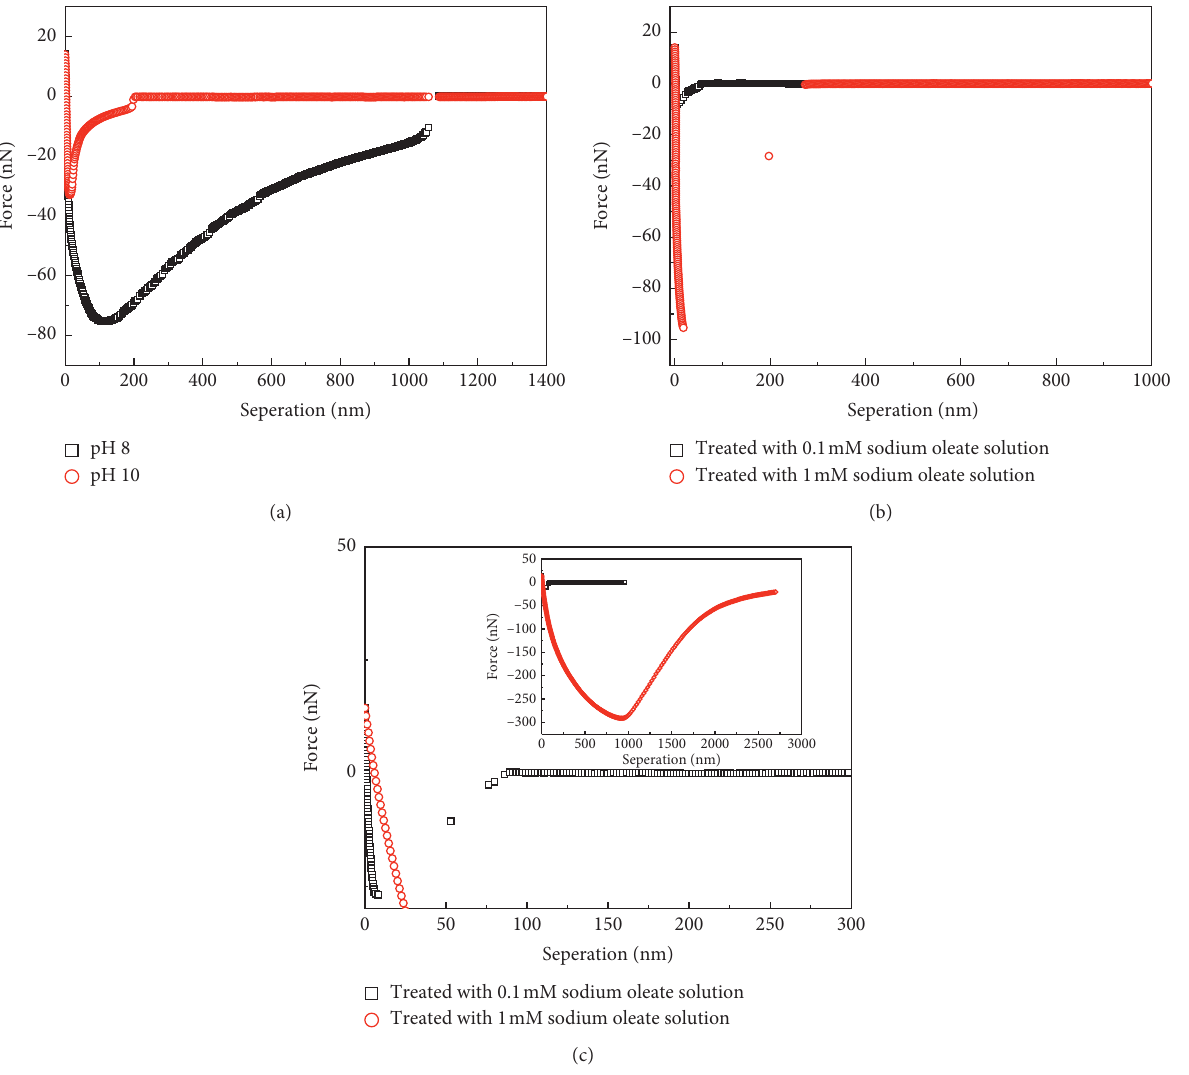
Figure 20: The retraction curves in sodium oleate solution: (a) scheelite-scheelite in 0.1mM sodium oleate solution; (b) scheelite-fluorite; (c)